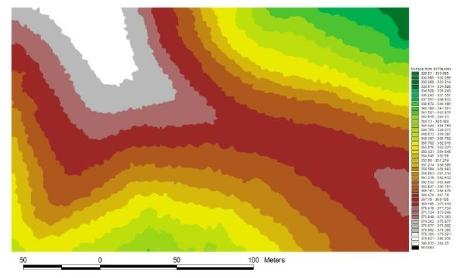
Figure 7. DEM created from reduced LiDAR data down to point cloud density of 0.101pts/m 2 .